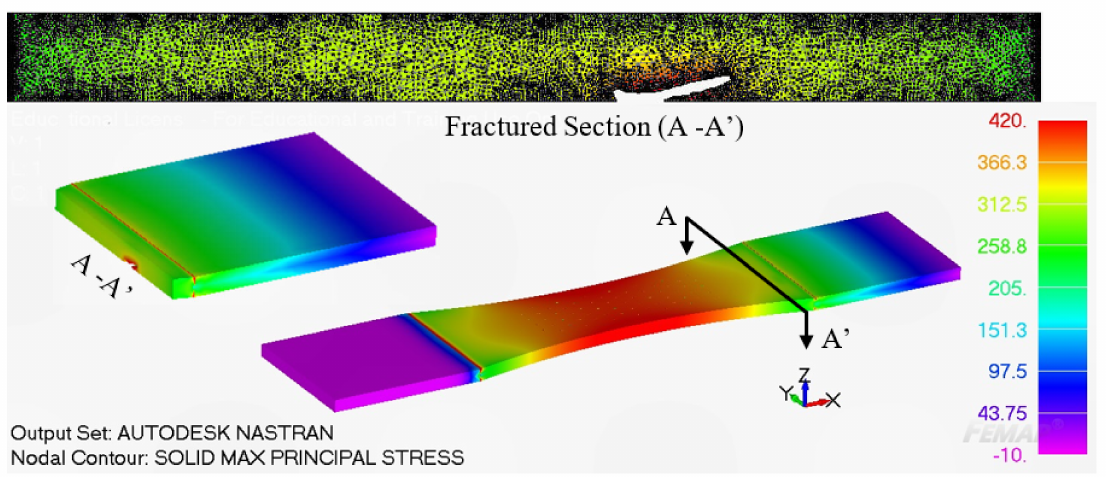
Figure 8. The maximum principal stress at a remote load of 50 kN, the stress units are in MPa. A durability analysis of this specimen was then performed, as per [28], using the fine mesh and Equations (1) and (2) together with the values of the parameters given √ √ in [28], viz: D = 2.0 × 10 − 10 , p = 2, A = 150 MPa m and ∆ K thr = 0.1 MPa m. (Details of the methodology used in the durability analysis can be found in [28].) The resultant computed and measured crack growth histories, post the mandated minimum equivalent initial damage size (EIDS) of 0.254 mm [4], are shown in Figure 9, where we see good agreement. In this analysis, the aspect ratio of the initial crack were taken to be as measured in the test, namely c / a = 1.67. Here, a is the crack depth, and 2 c is the crack’s total length in the direction perpendicular to the crack’s maximum depth.